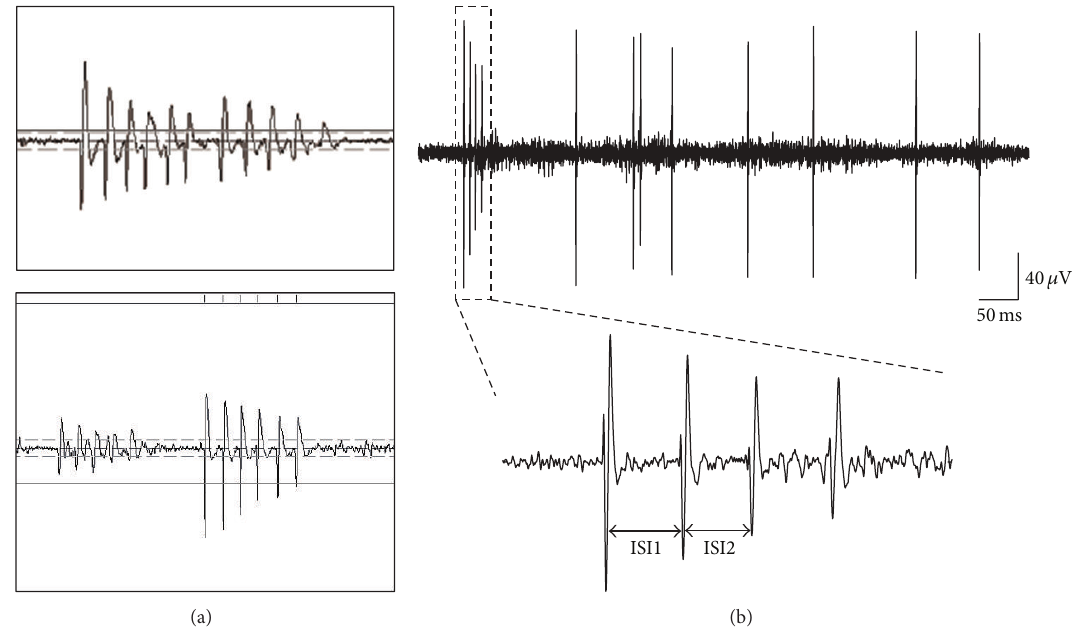
Figure 2: Examples of spontaneous firing of pyramidal neurons recorded from hippocampal CA1 area. (a) Examples of two bursting neurons recorded in one channel. The upper panel showed two bursting neurons whose spike waveforms were too close to be cleanly sorted. The lower panel was an example that the burst can be cleanly sorted to a single unit. (b) An epoch of spontaneous firing which includes a four-spike burst and several single spikes to show the quality of our signal. The burst is exaggerated below. ISI1 is the interval between the second and the first spike while ISI2 is the interval between the third and the second